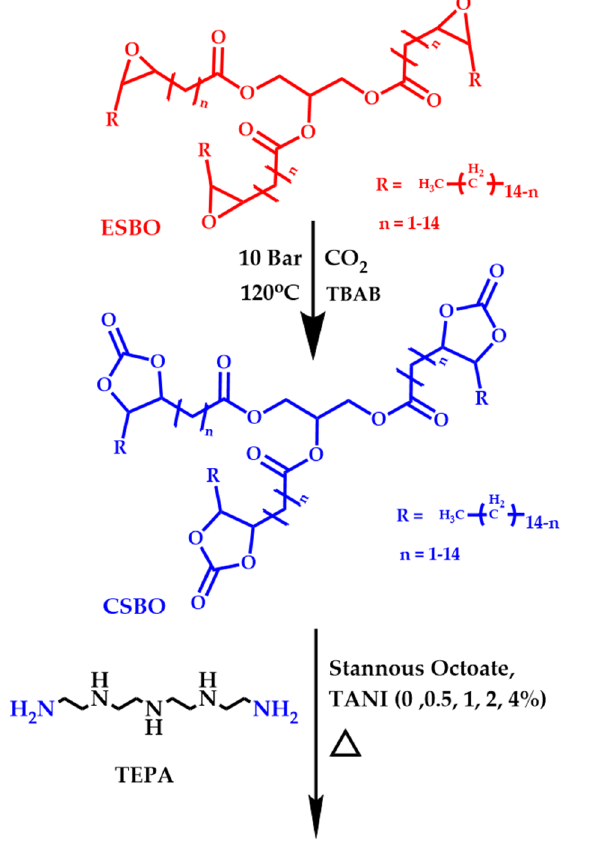
Figure 1. Images of ESBO and CSBO Resin .